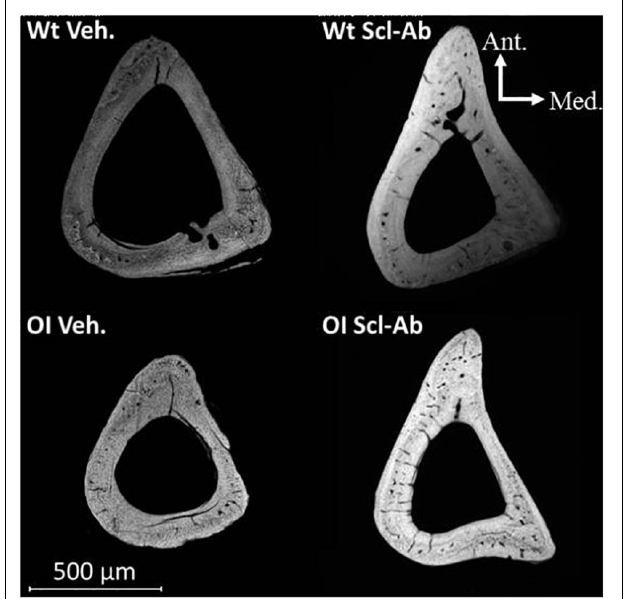
FIGURE 6 | Fluorescence microscopy aspect of cross sections through the tibias of male Wt Veh., Wt Scl-Ab, OI Veh., and OI Scl-Ab mice. Green lines correspond to calcein injections at experimental days 1, 21, 42, and